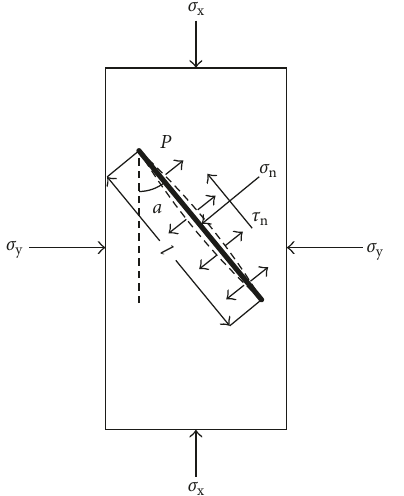
Figure 2: Compressive shear model of rock mass with the single crack under pore